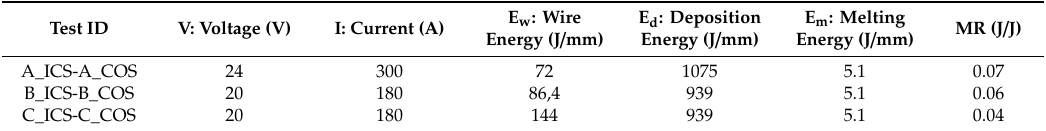
Table 3. Process parameters for the manufacture of IN718 WAAM wall.